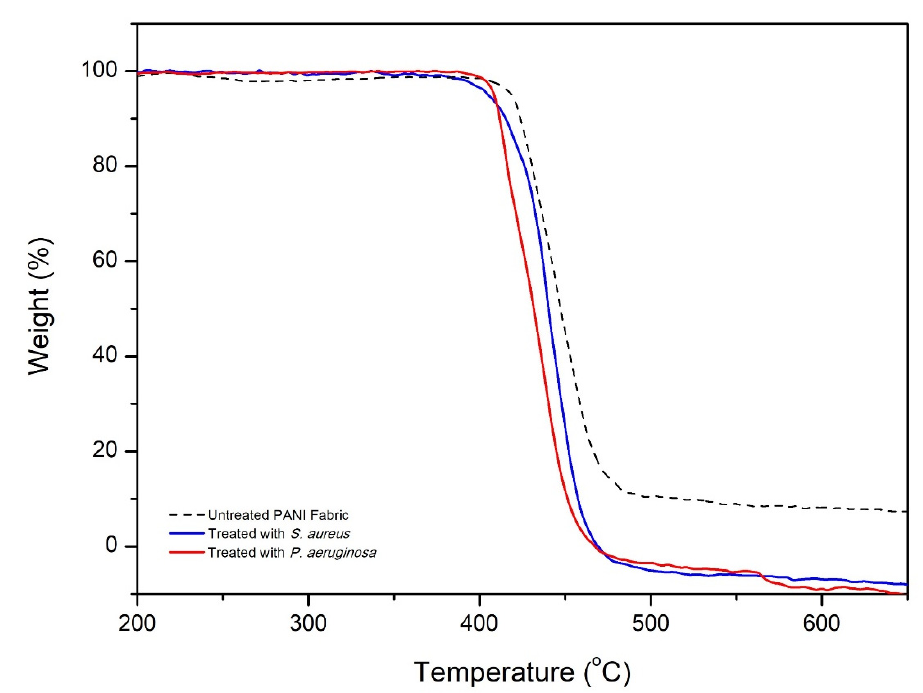
Figure 10. The thermogravimetric weight loss curves of untreated PANI fabric, and of PANI fabric treated with S. aureus and P. aeruginosa strains.